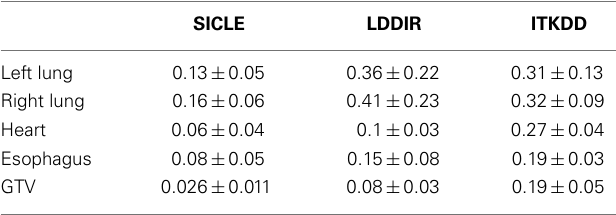
Table 2 | Standard deviation of differential Jacobian volume histogram averaged over 13 patients